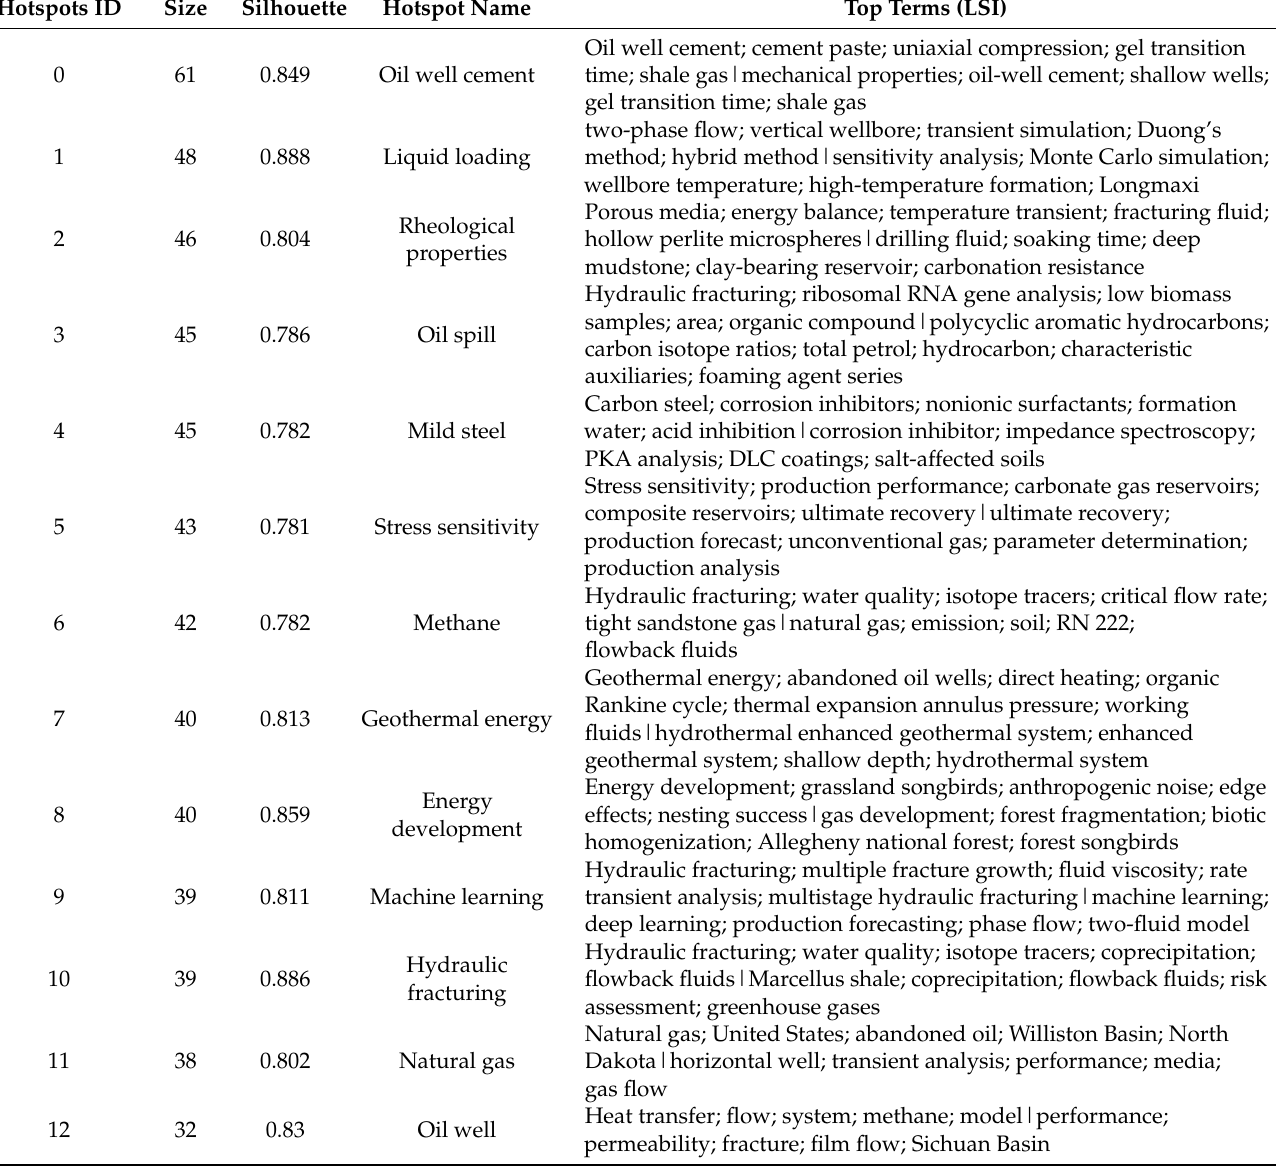
Table 3. Hotspot information statistics in the field of oil and gas wells